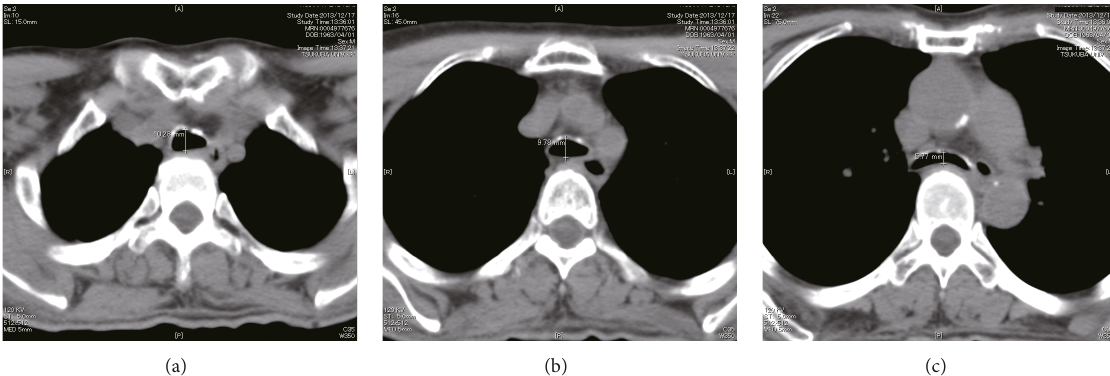
Figure 1: Chest computed tomography 1.5 months previously. (a) The anteroposterior diameter of the trachea at 3 cm away from the glottis was 10.3 mm. (b) The anteroposterior diameter of the trachea at 6 cm away from the glottis was 9.8 mm. (c) The anteroposterior diameter of the tracheal bifurcation at 9cm away from the glottis was 5.8 mm.